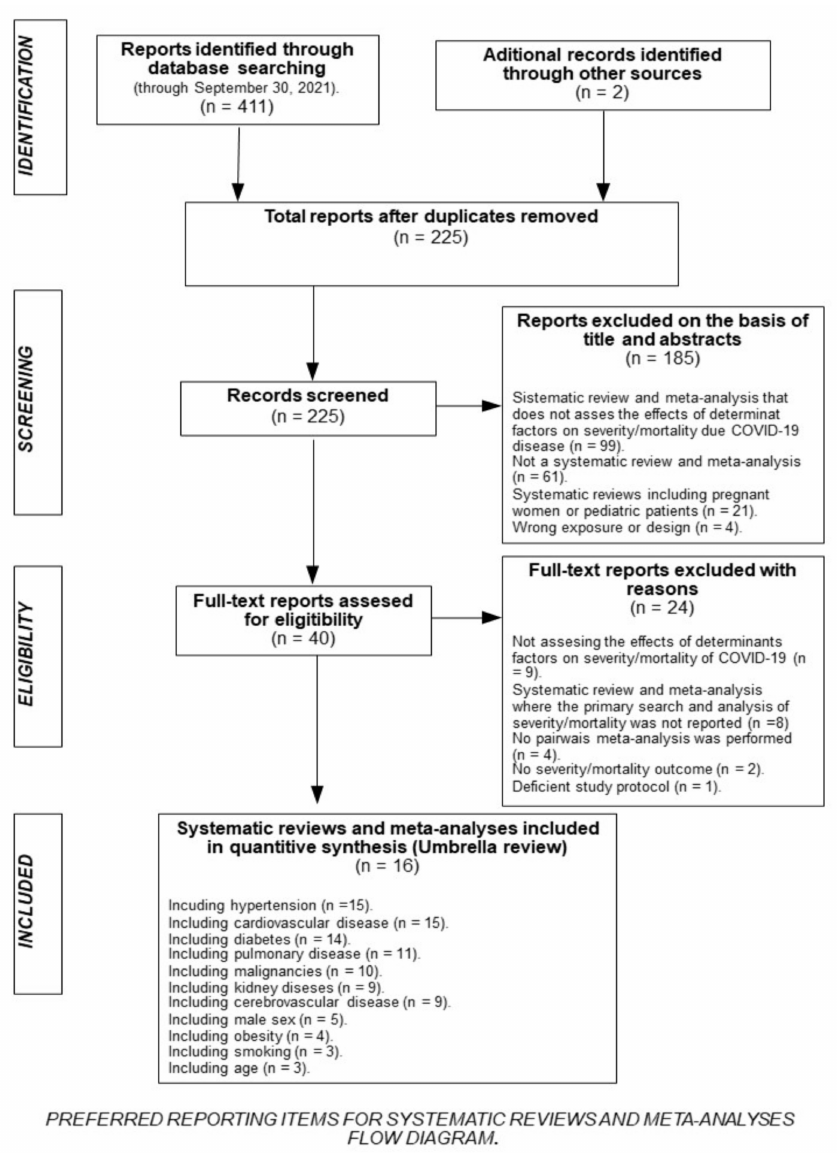
Figure 1. Flow chart of included articles according to